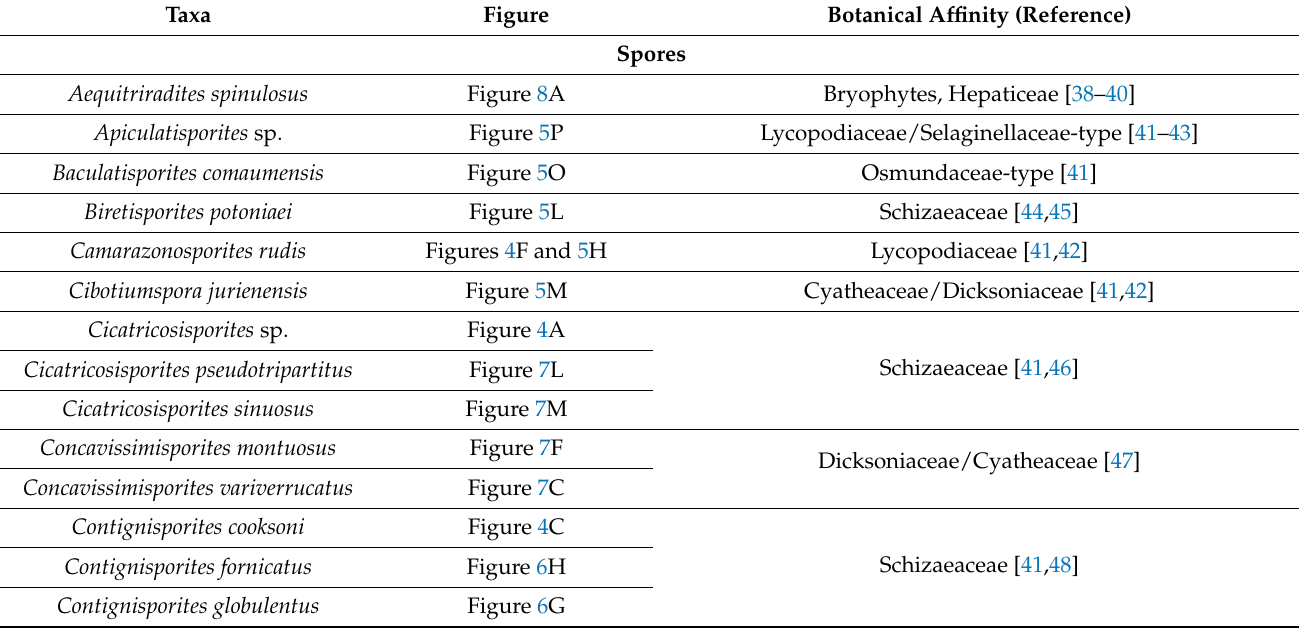
Table 1. Palynomorphs identified in the Lastres Fm., with their botanical